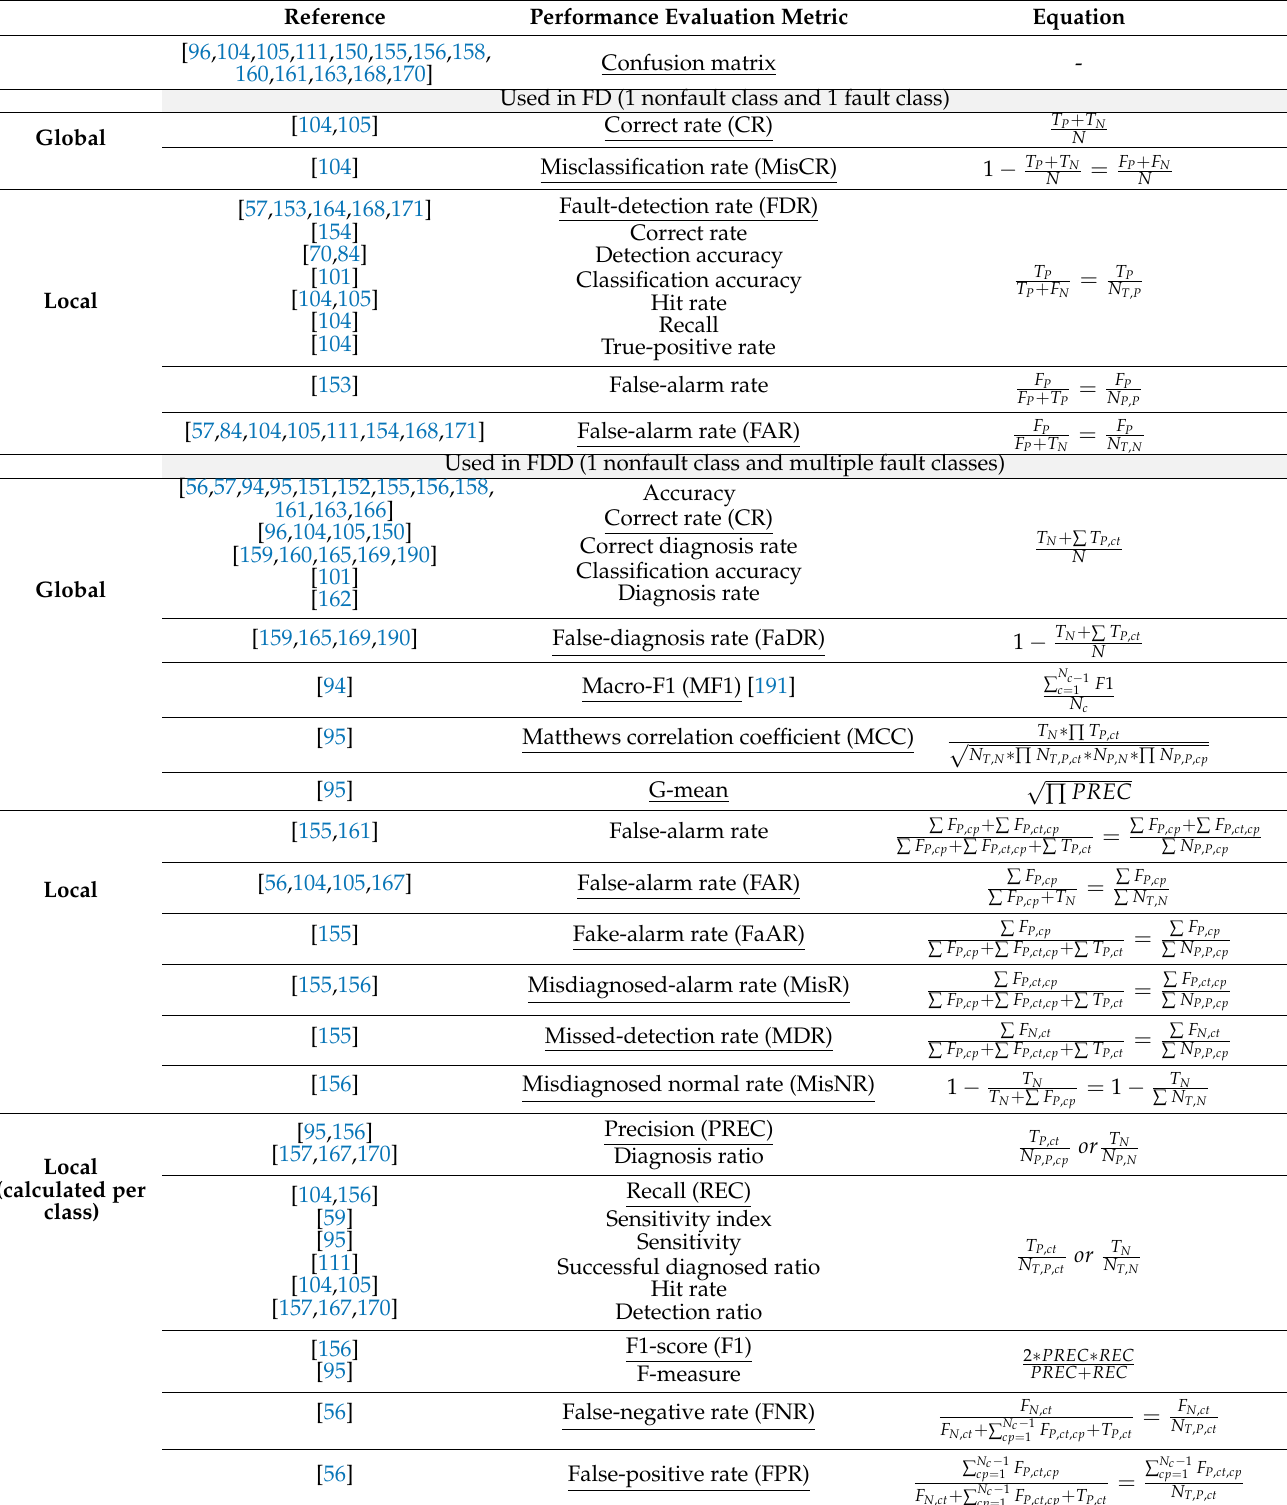
Table 11. The performance evaluation metric with an underscore is the name suggested for future application to avoid confusion. The references in bold specifies precisely how the metric was calculated and the name of the metric. The references without bold text only stated the name of the metric, and not the numerical